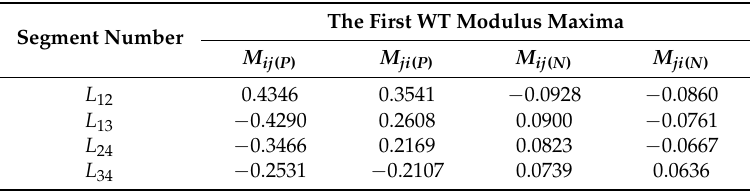
Table 2. Location results of monopolar fault.